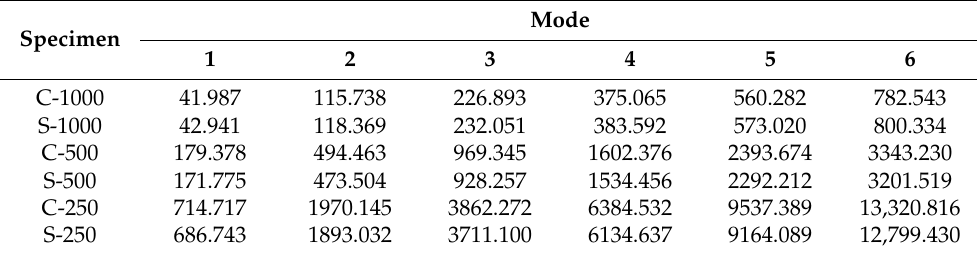
Table 14. Natural frequencies obtained from analytical modelling (in